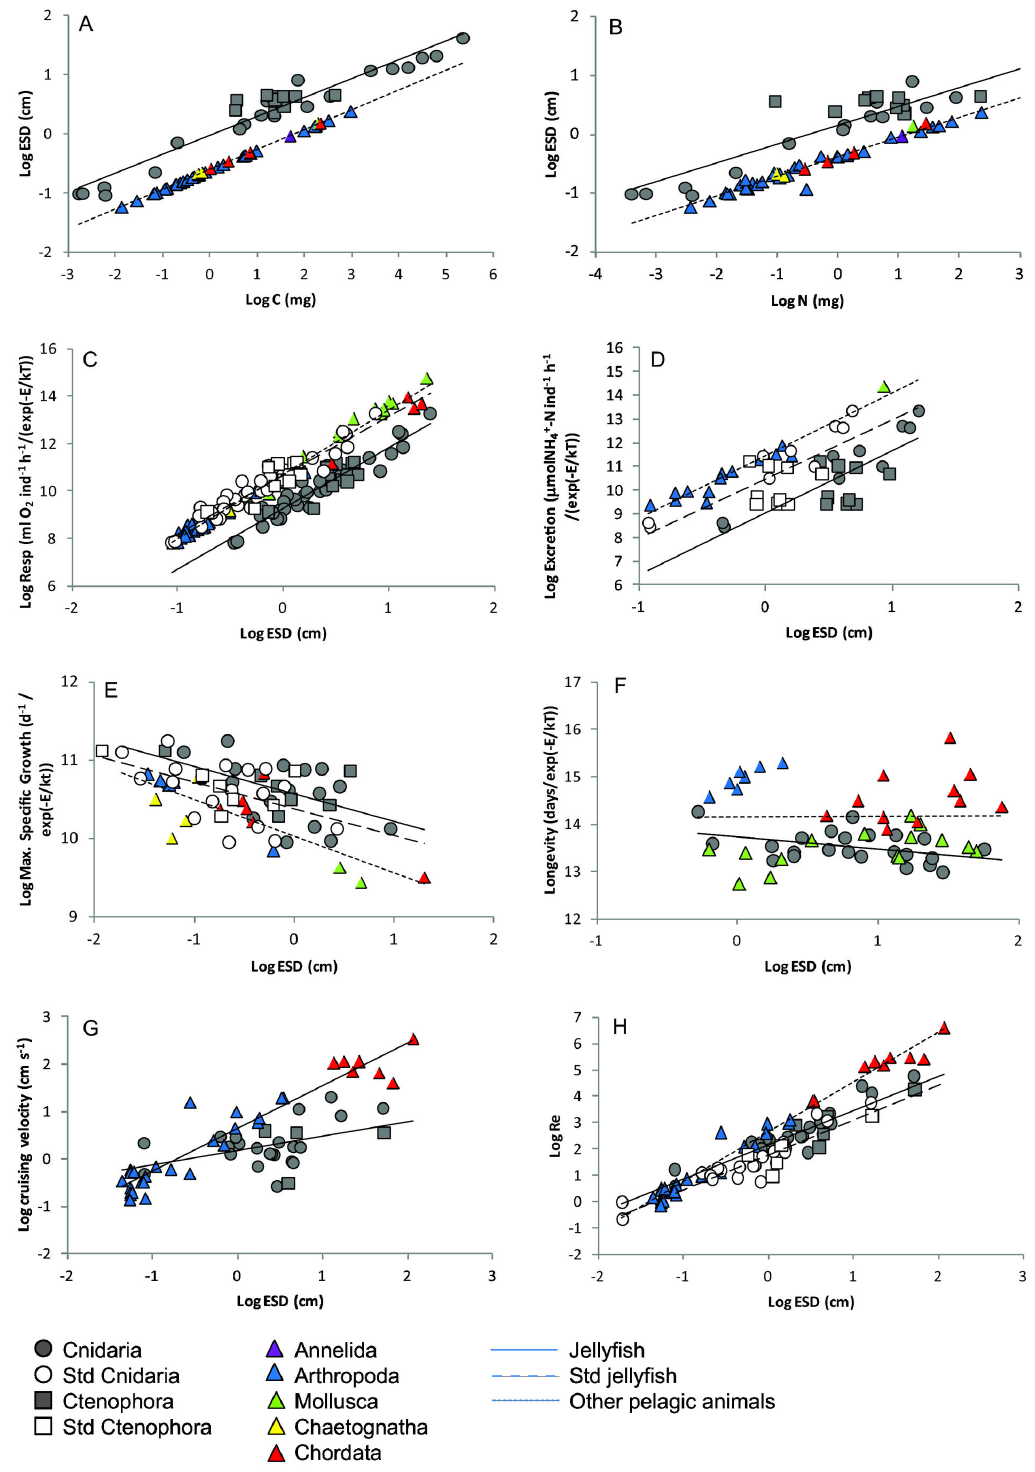
Figure 1. Animal size (equivalent spherical diameter; ESD) as a function of carbon content (A) and nitrogen content (B) for jellyfish and other pelagic animals. Respiration (C), excretion (D), maximum specific growth (E), longevity (F), swimming velocity (G), and Reynolds numbers (H) as a function of ESD for jellyfish, other pelagic animals, and jellyfish whose ESD is standardised for their carbon content. Data and data sources are available in electronic supplementary material (Dataset S1; Appendix S1). doi: 10.1371/journal.pone.0072683.g001 PLOS ONE |